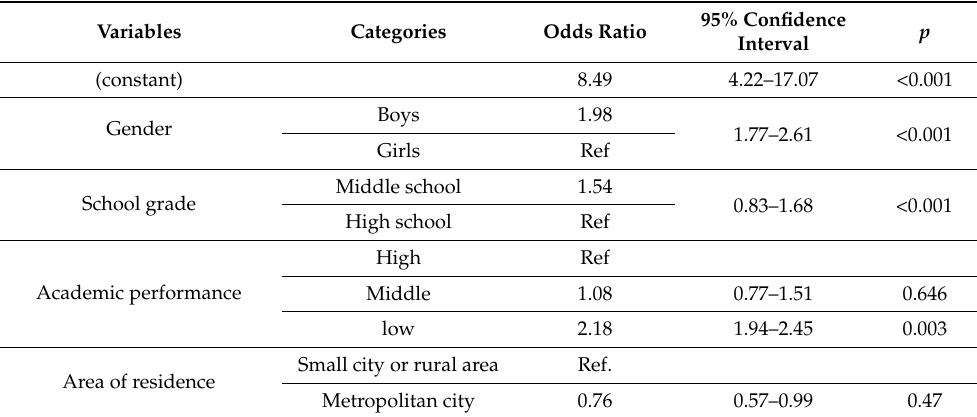
Table 3. Factors of mental health and smoking-related characteristics on drinking experience in